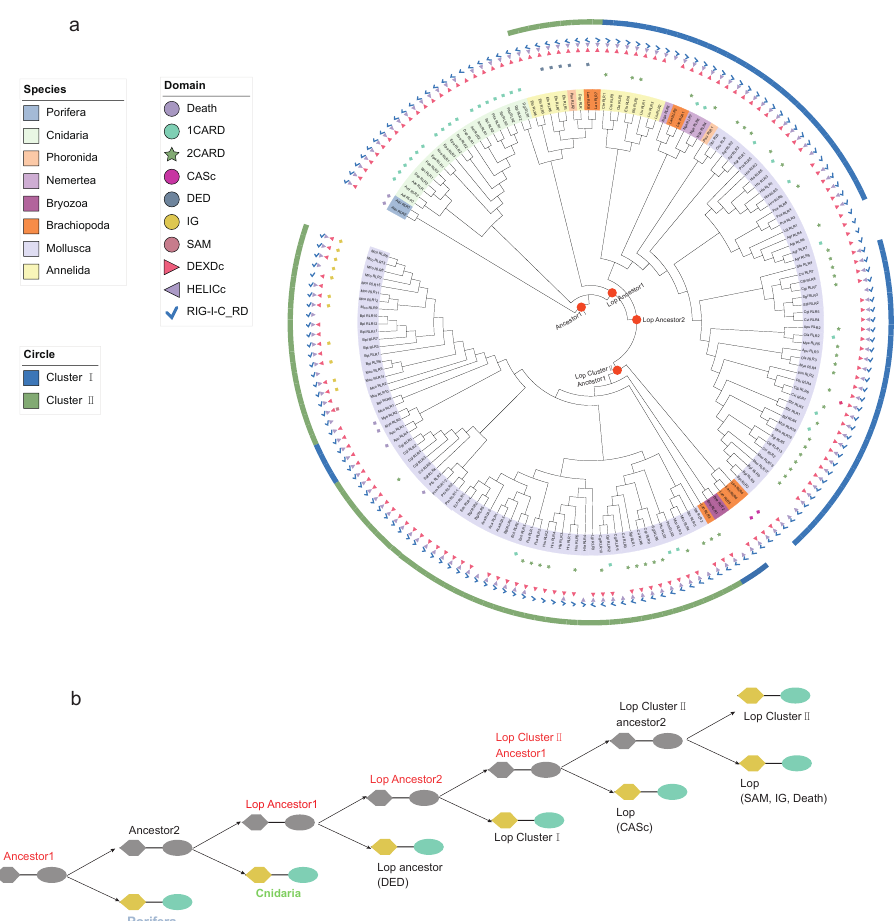
Figure 4. The evolution of intermediate helicase domains (DEXDc + HELICc domains) of the lophotrochozoan RLRs . ( a ) Phylogenetic tree constructed with the maximum likelihood method showing the evolution of DEXDc + HELICc domains of RLRs in loptrochozoans. The different background colors of the gene names represent the phyla to which they belong, as shown in the legend ‘Species’. The different colored shapes represent different domains, as shown in the legend ‘Domain’. The blue arc in the outermost circle represents Cluster I, and the green arc represents Cluster II. The orange circles on the branches marked on the tree correspond to the evolutionary divergent nodes as shown in ( b ). ( b ) A schematic diagram of the evolution of the intermediate helicase domains of lophotrochozoan RLRs based on the phylogenetic tree. Lop stands for the lophotrochozoan. Solid black lines indicate duplication